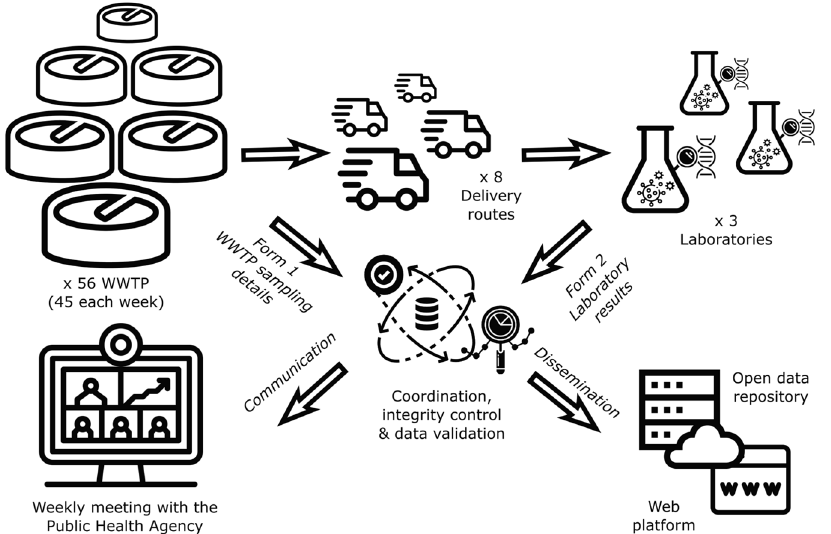
Figure 3. Communication pipeline of